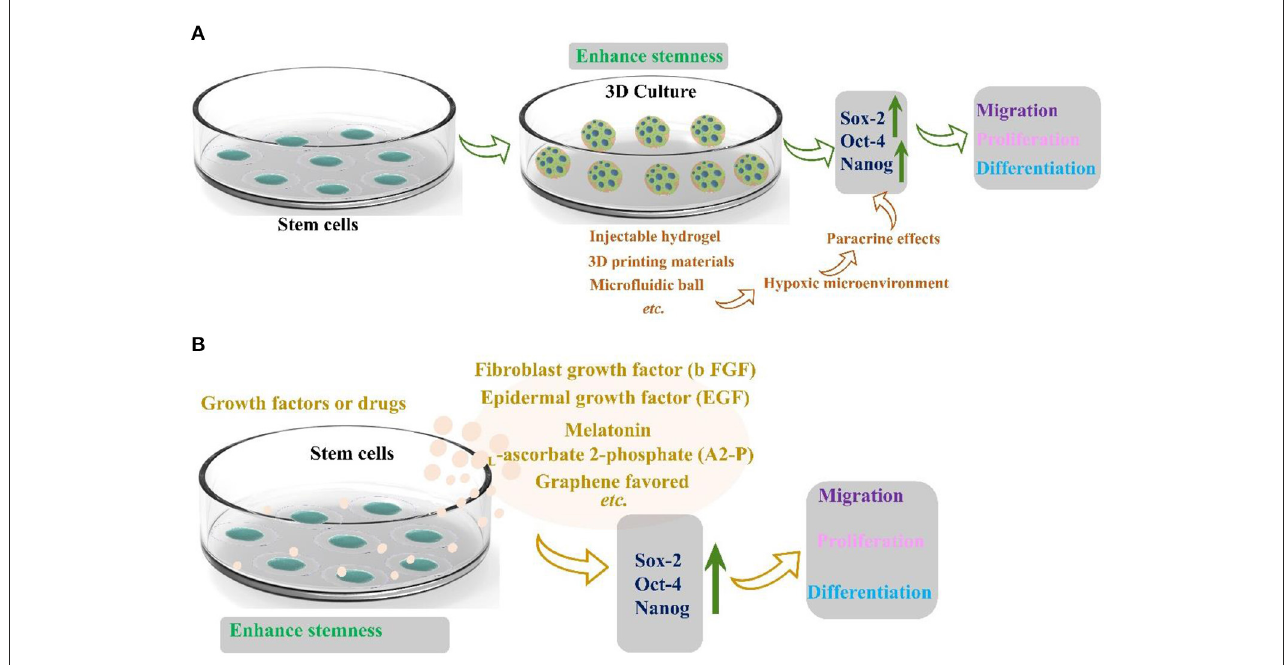
FIGURE5 (A) Three-dimensional structure maintains the stemness of stem cells reprinted (adapted) with permission from (47), Copyright (2022) American Chemical Society. (B) Growth factors and drugs maintain the stemness of stem cells